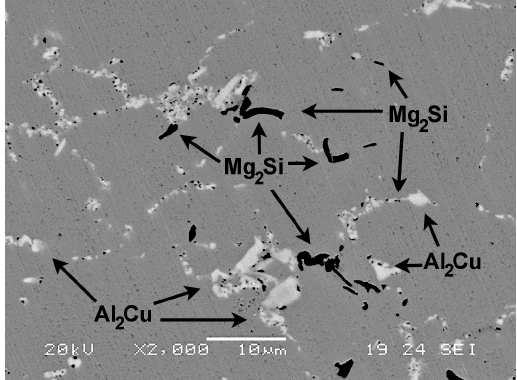
Figure 7. Microstructure after hot rolling of the material with a 90% reduction in cross ‐ section, obtained by scanning electron microscopy. Particles of Mg 2 Si (black coloring) and Al 2 Cu (white coloring) identified by semi ‐ quantitative analysis by characteristic energy dispersive X ‐ ray (EDX) microanalysis.